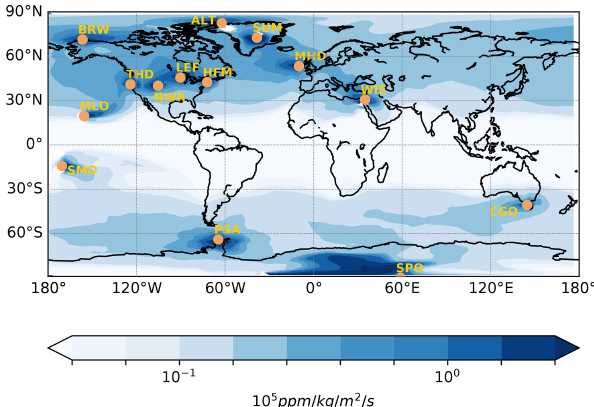
Figure 1. Annual climatology of Jacobians computed by the adjoint of the LMDz model: map of the partial derivatives, in ppmkg − 1 m − 2 s − 1 , of a monthly mean concentration at all stations from the NOAA network with respect to CO 2 surface fluxes in the 2 previous months. The yellow dots denote the location of the surface sites. The site KUM is not depicted as it has the same coordinates as MLO but at sea